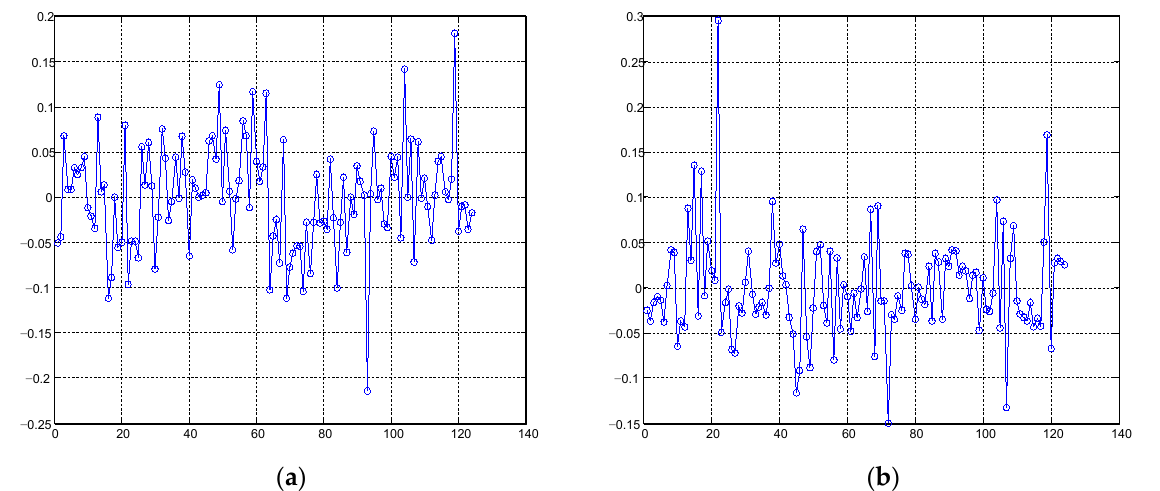
Figure 11. Matching error of the tie-points in the strip, where ( a ) is the range direction and ( b ) is the azimuth direction.